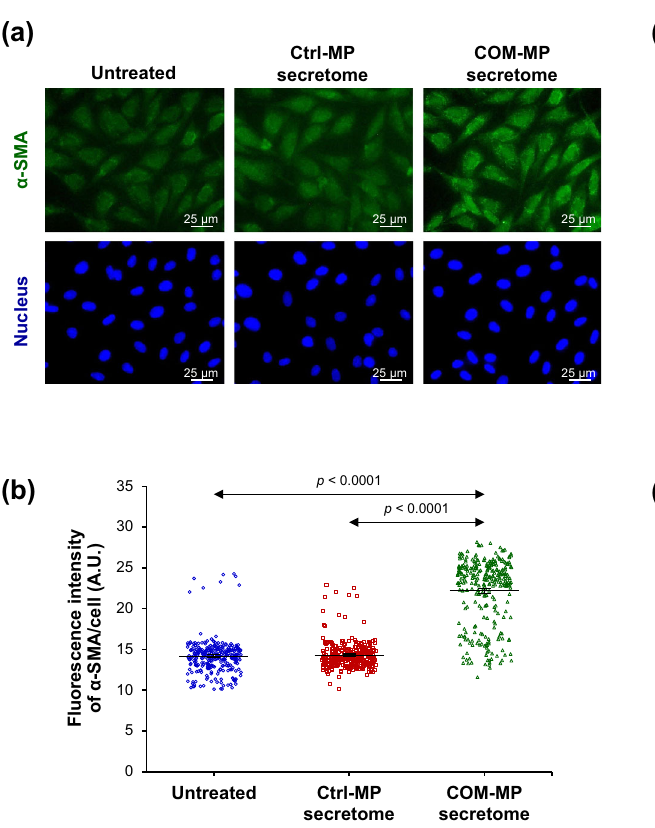
Fig. 6 Effects of COM-MP secretome on α -SMA level in BHK-21 renal fi broblasts. BHK-21 cells were incubated in fresh serum-free medium without any treatment (untreated control) or in fresh serum-free medium mixed 1:1 (v/v) with Ctrl-MP secretome or COM-MP secretome for 24 h. a Immuno fl uorescence staining of α -SMA was done using mouse monoclonal anti- α -SMA as a primary antibody, whereas secondary antibody was conjugated with Alexa Flour 488. Nuclei were stained in blue using Hoechst dye. b Quantitative analysis of fl uorescence intensity of α -SMA was obtained from at least 100 cells in ≥ 10 random HPFs for each sample using NIS-Elements D V.4.11 (Nikon). The data were obtained from three independent experiments using different biological replicates and the bars indicate mean ± SEM (all the source data are presented in Supplementary Data 3). A.U. = arbitrary unit.